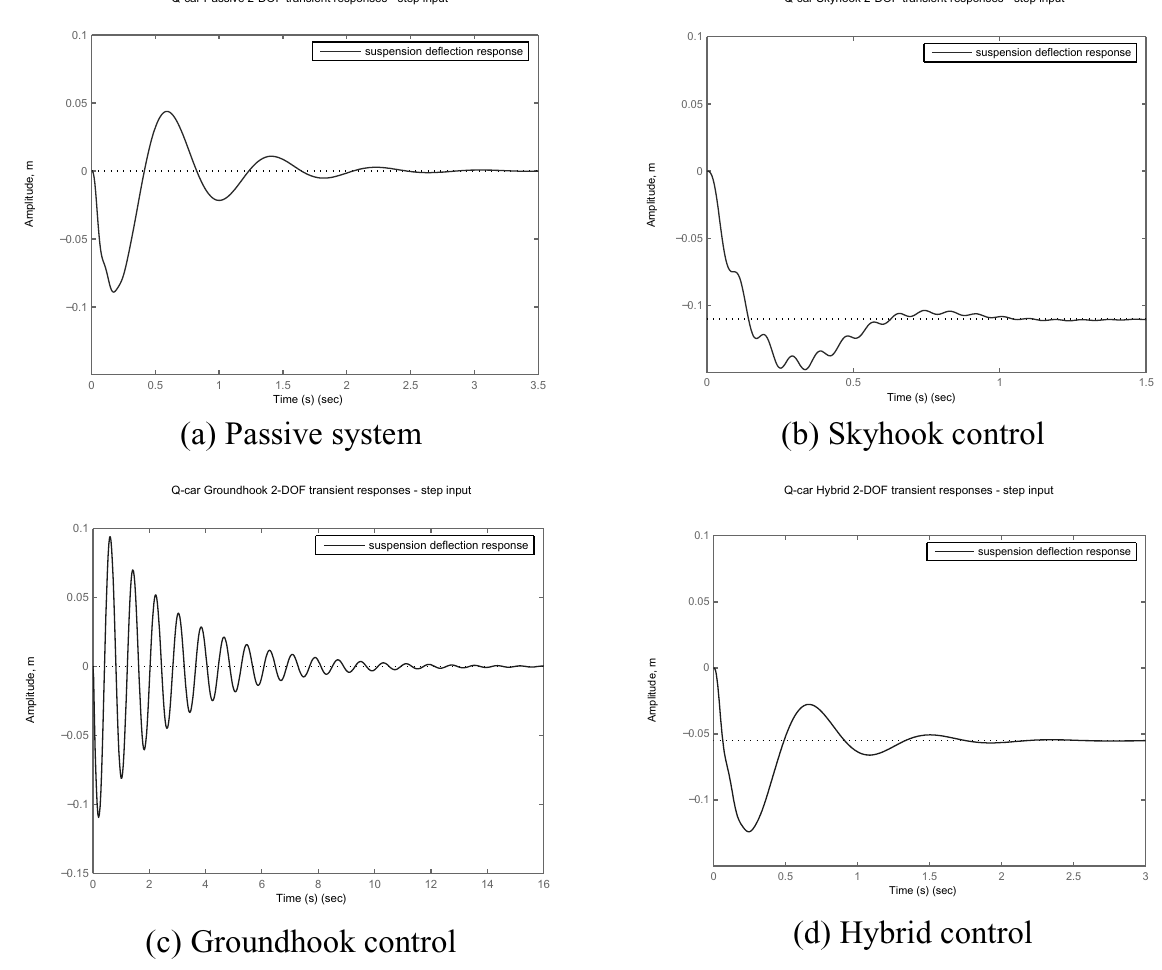
Fig. 4. Suspension deflection